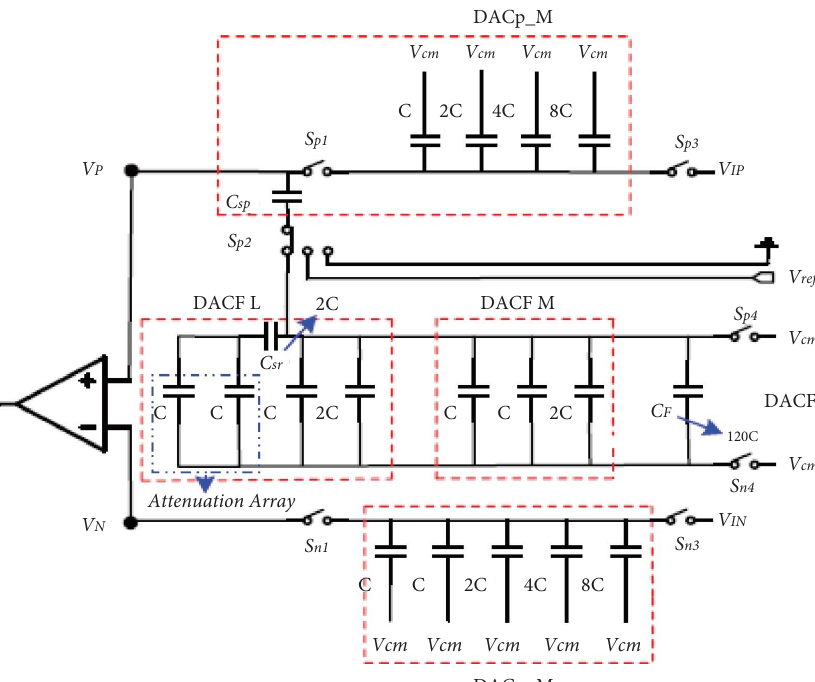
Figure 19: Te asymmetric switching with the segment CDAC